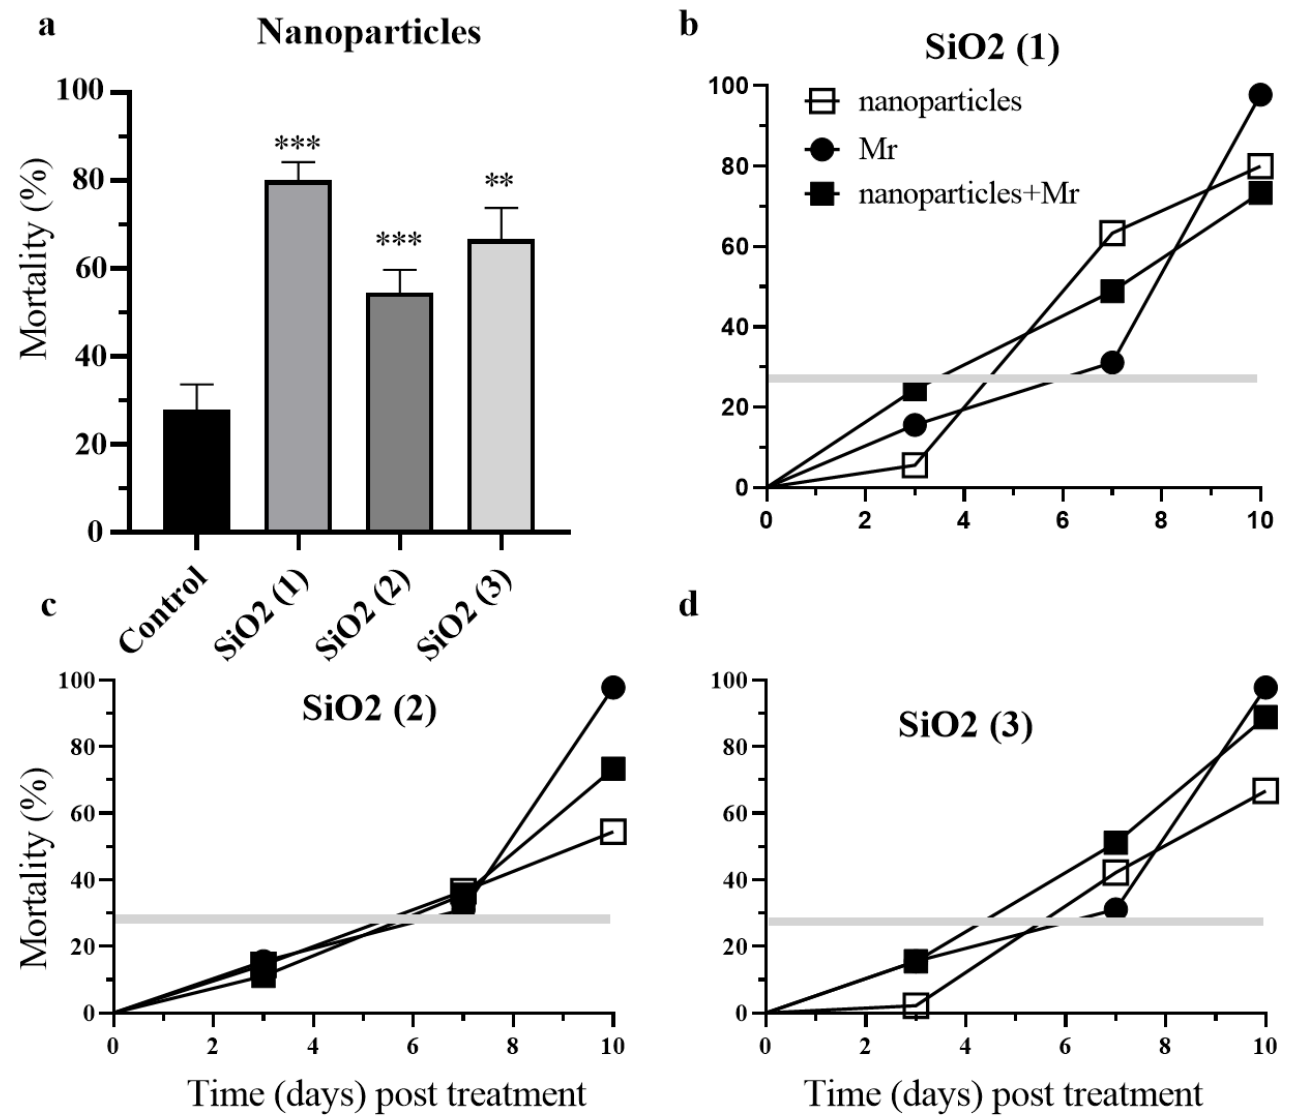
Figure 4. Survival of crucifer flea beetles Phyllotreta spp. imagoes over ten days following treatment with silicon dioxide nanoparticles with epoxy (1 SiO 2 ), silane (2 SiO 2 ), amino (3 SiO 2 ) groups ( a ), fungus Metarhizium robertsii (Mr) and combination (Mr + nanoparticles) ( b – d ); ** p < 0.01; *** p < 0.001 compared with native beetles (Control) ( a ).